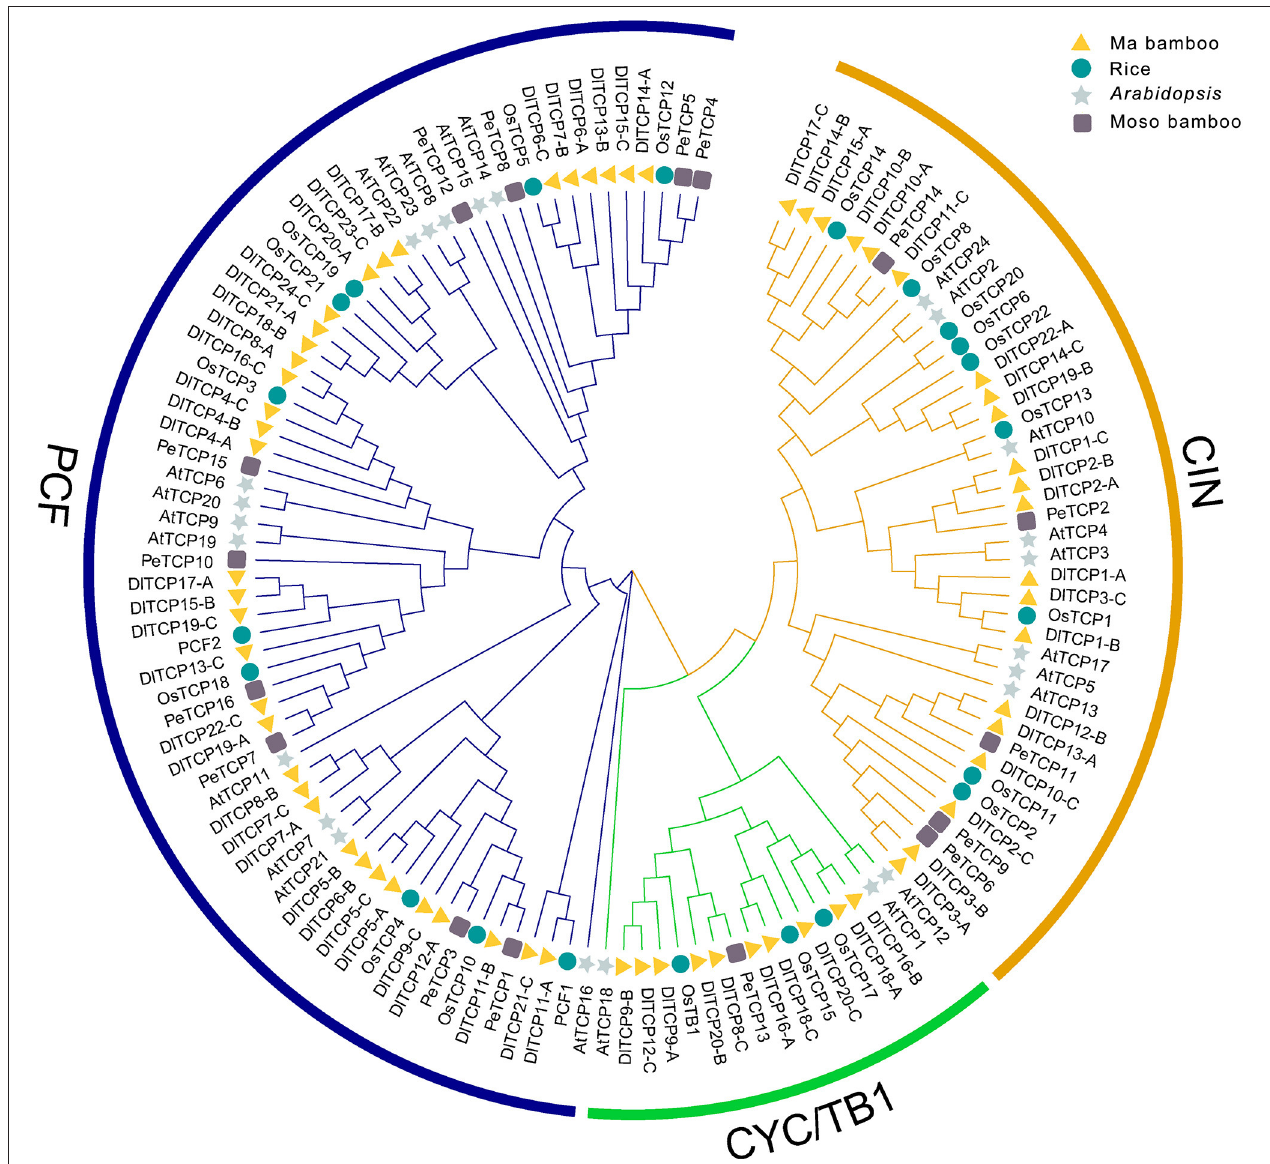
FIGURE 1 | Phylogenetic analysis of TCP members in Ma bamboo, Moso bamboo, rice, and Arabidopsis. MEGA7.0 was used to construct phylogenetic tree by neighbor-joining (NJ) method divided the TCP family into two clades with 1,000 bootstraps replication. Triangle, round, star, and square represent the TCP members of Ma bamboo, rice, Arabidopsis, and Moso bamboo, respectively. Different colored geometric shapes were used to mark TCP members of different